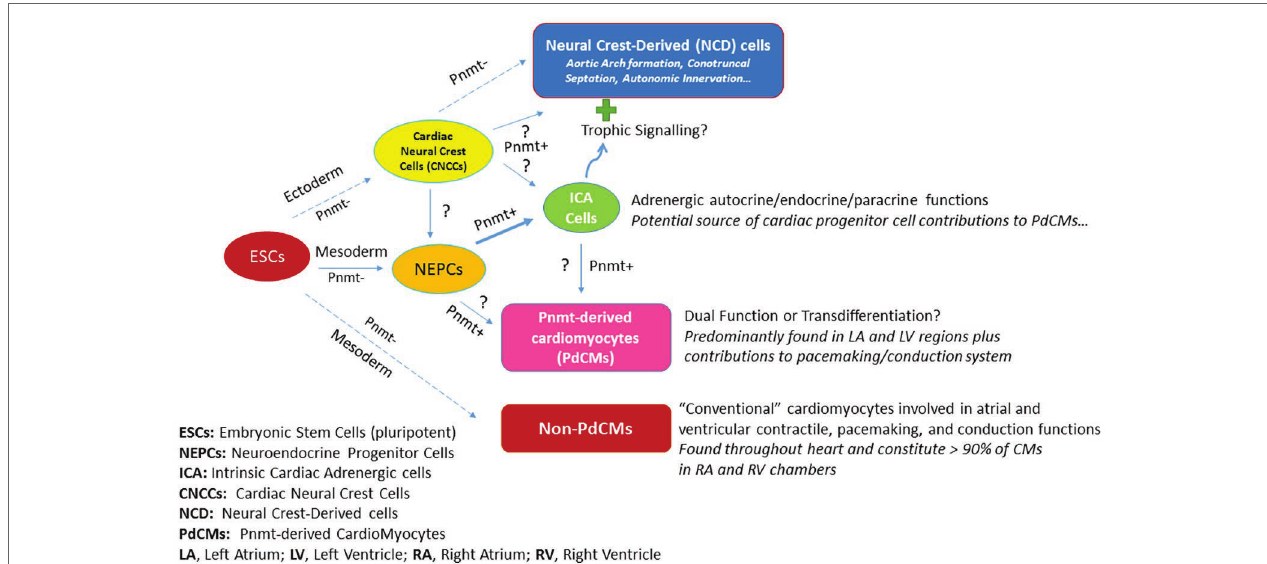
FIGURE 2 | Schematic depiction of how PdCMs are thought to arise in heart